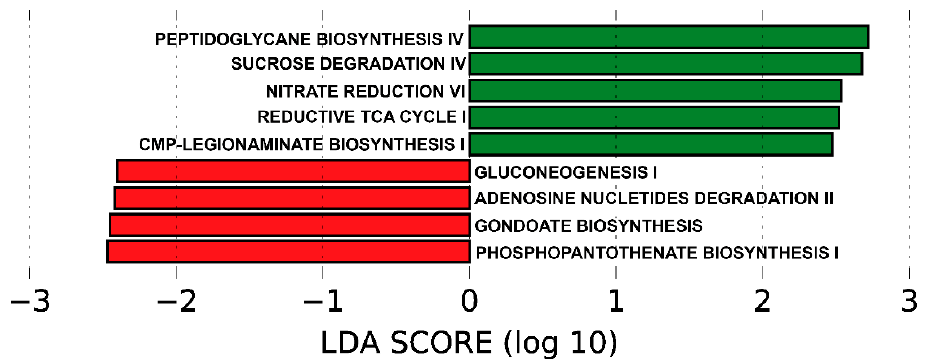
Figure 3. Predicted functional composition of metagenomes based on 16SrRNA gene sequencing data. LEfSe based on the PICRUSt2 dataset revealed differentially enriched metabolic pathways as- sociated with PPARGC1A genotypes 1 and 2 (PPARGC1A-1 (red); PPARGC1A-2 (green)). LDA: lin- ear discriminant analysis.